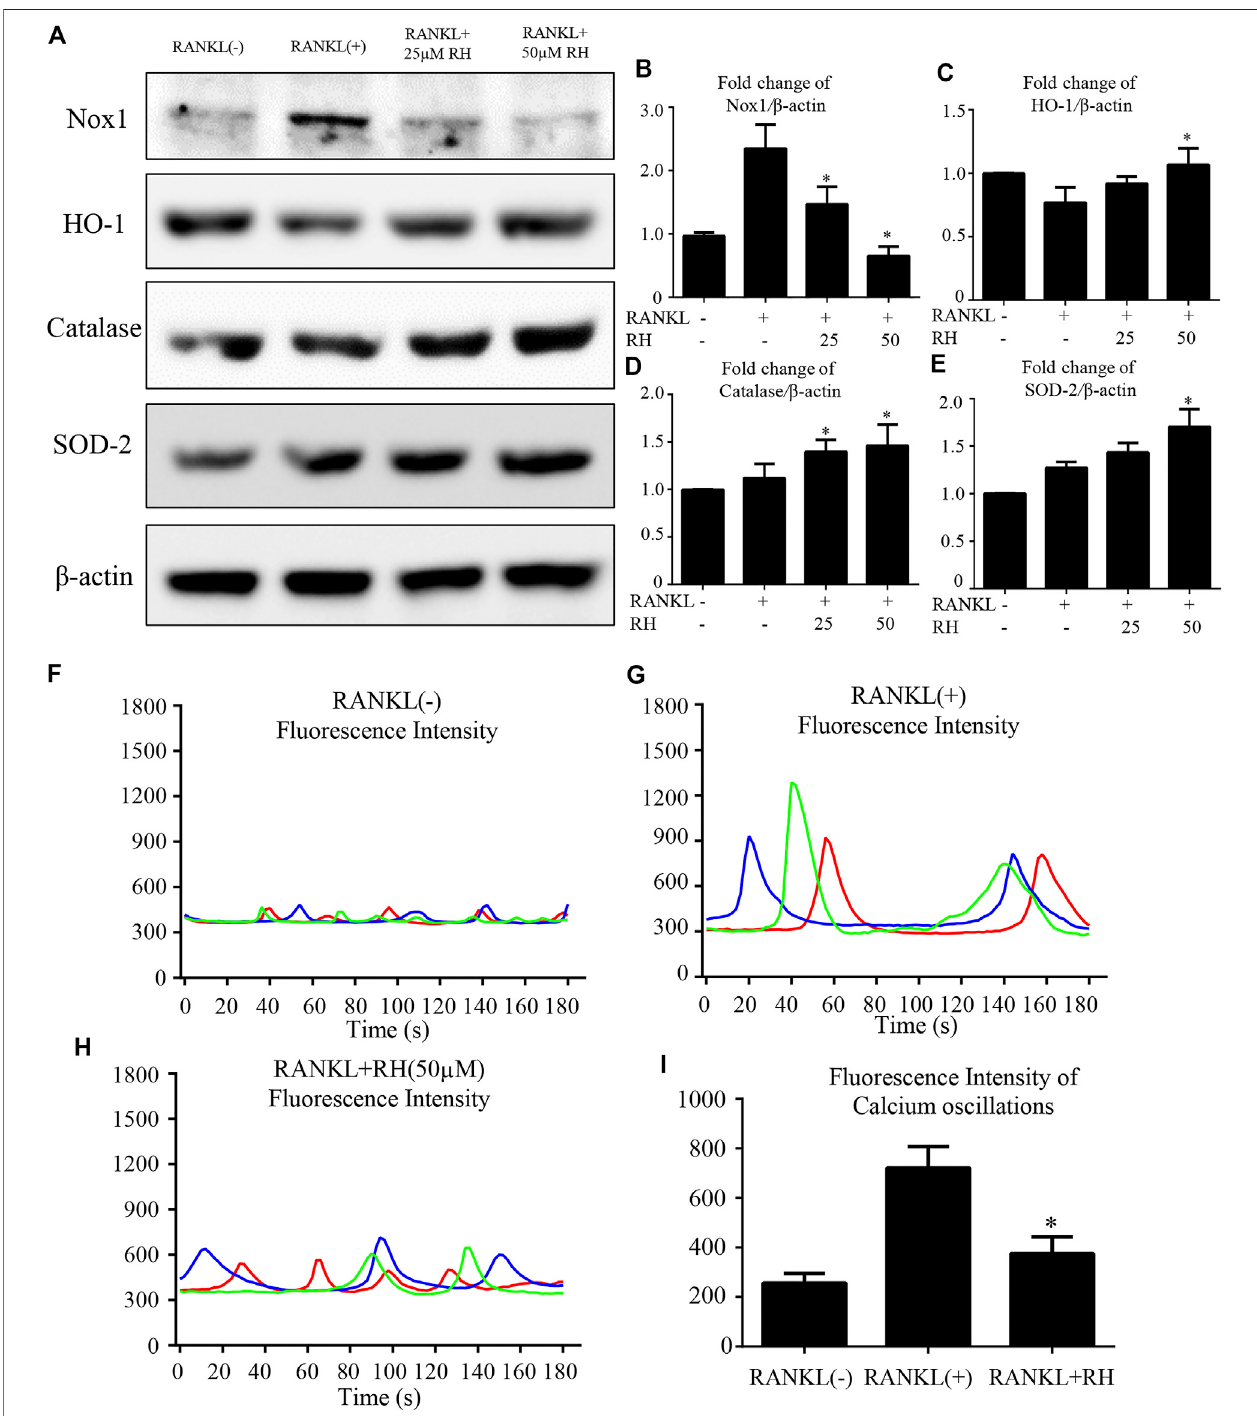
FIGURE 5 | RH suppressed RANKL-induced ROS activity and Ca 2+ oscillation. (A) Representative Western blot images of the Nox1, catalase, HO-1, and SOD-2 expression with the treatment of RH, the Nox1 expression was signi fi cantly suppressed by RH, and the antioxidant enzymes of HO-1, catalase and SOD-2 were enhanced. BMMs were stimulated with RANKL (50 ng/mL) with RH at the concentration of 25 and 50 μ M or PBS for 2 days before collecting protein. (B – E) Quanti fi cation of the ratios of band intensity of Nox1, HO-1, catalase, and SOD-2 relative to β -actin ( n (cid:2) 3 per group). * p < 0.05, ** p < 0.01 comparison with the RANKL-induced positive control group. (F – H) Representative images of fl uorescence intensity waves of Ca 2+ oscillation in negative group, RANKL stimulated positive group and RH (50 μ M) treated group. There were three colours indicating different cells in each group. (I) Quanti fi cation of fl uorescence intensity change of Ca 2+ oscillation in each group. * p < 0.05, ** p < 0.01 relative to RANKL-induced positive control group.